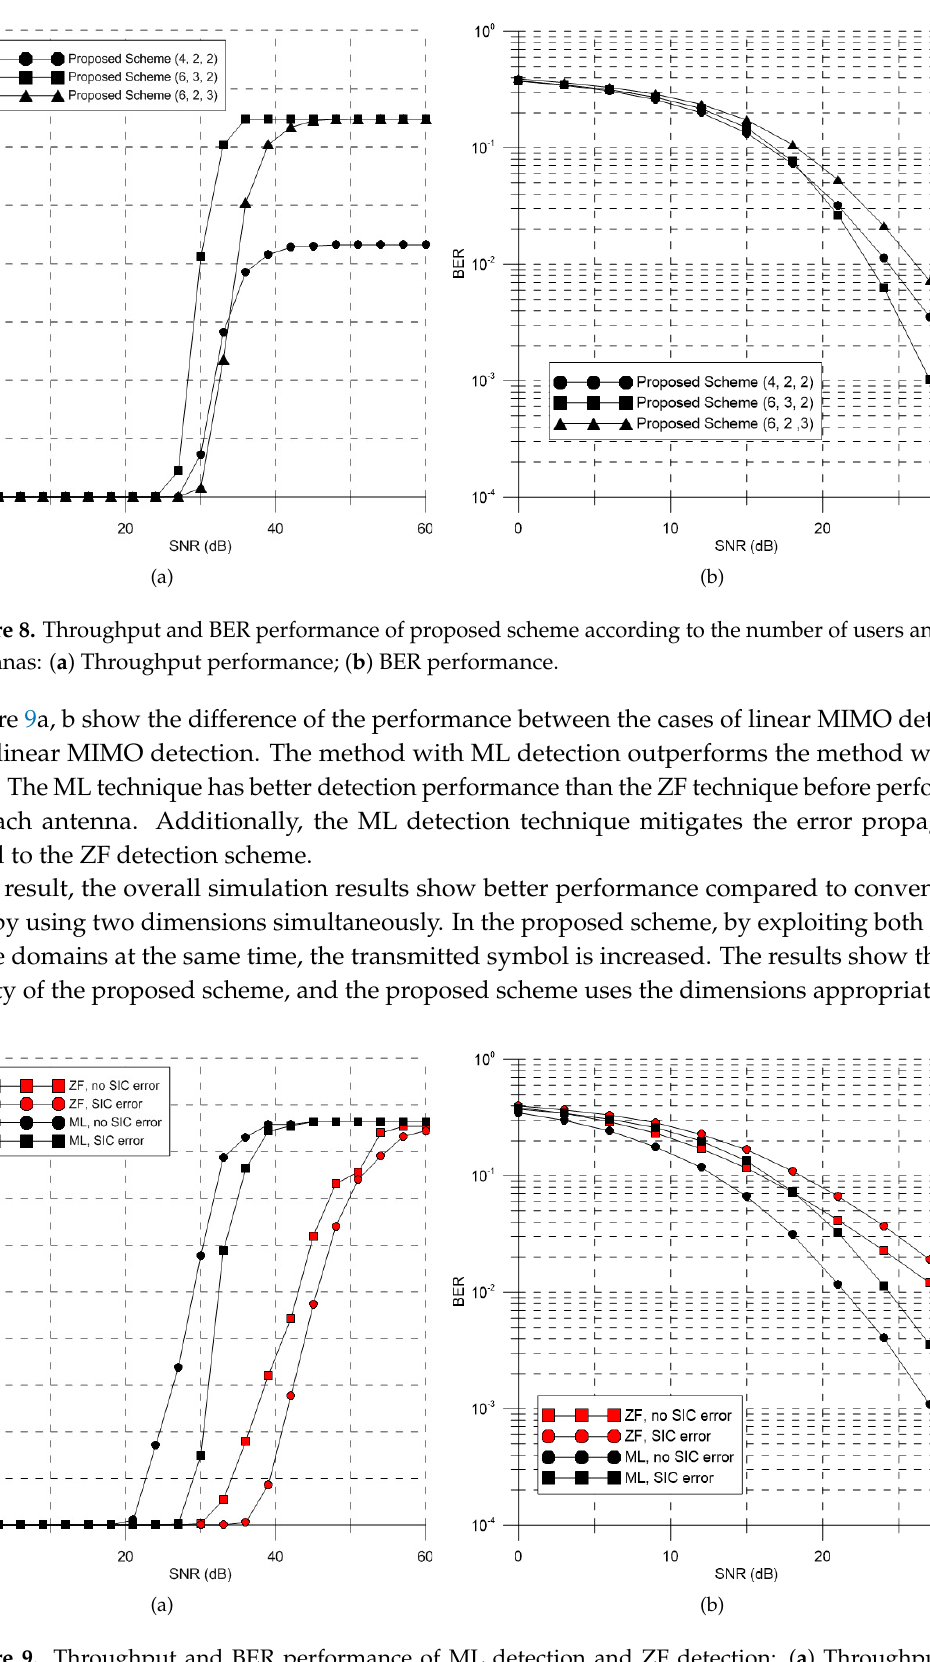
Figure 9. Throughput and BER performance of ML detection and ZF detection: ( a ) Throughput performance; ( b ) BER